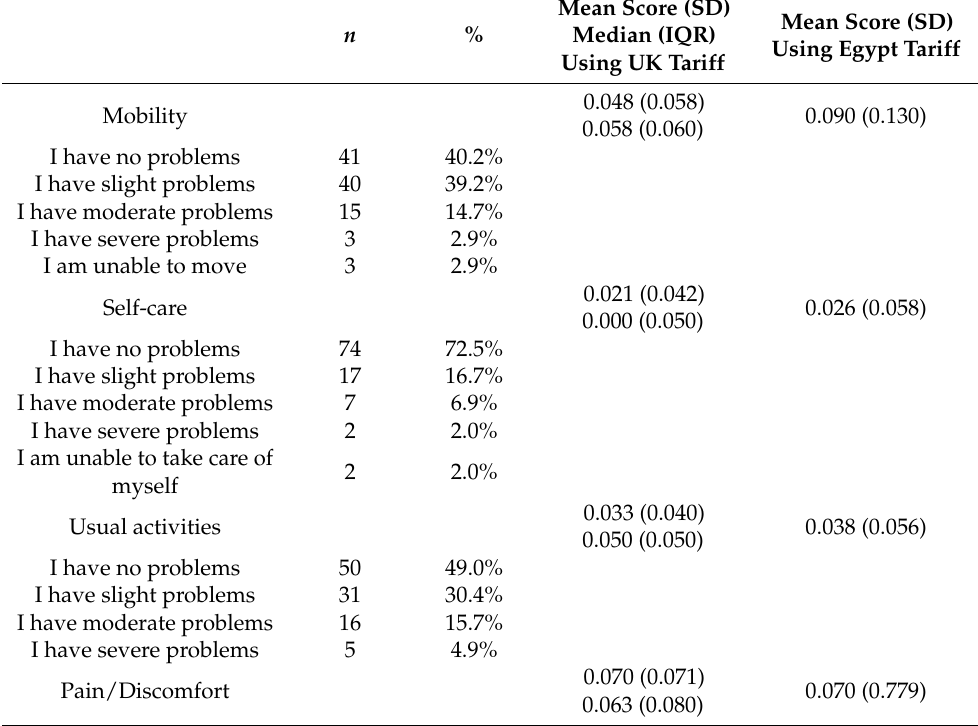
Table 3. Descriptive statistics for EQ-5D-5L items and